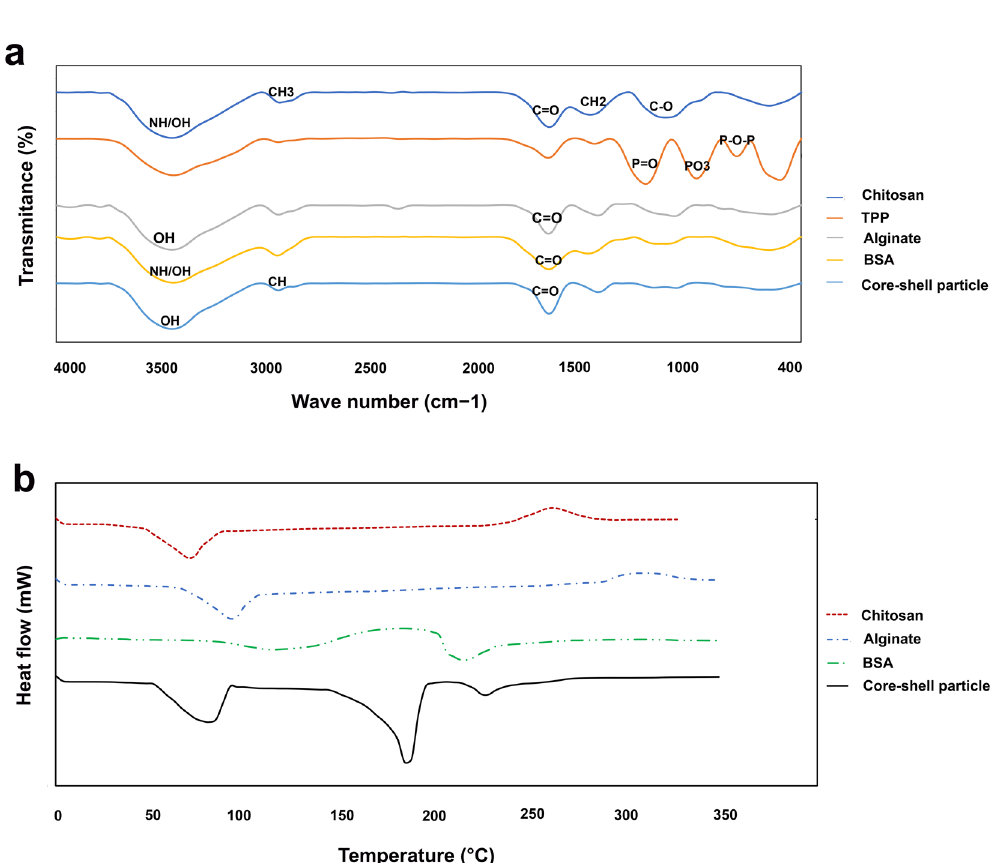
Figure 2. ( a ) FTIR spectra of chitosan, TPP, alginate, BSA, and BSA-loaded chitosan-alginate particle, and ( b ) DSC analysis of chitosan, alginate, BSA and BSA-loaded chitosan-alginate